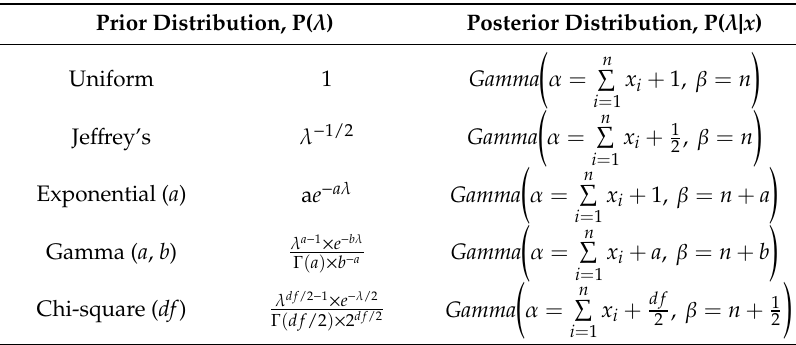
Table 2. Prior and posterior distributions for Bayesian interval